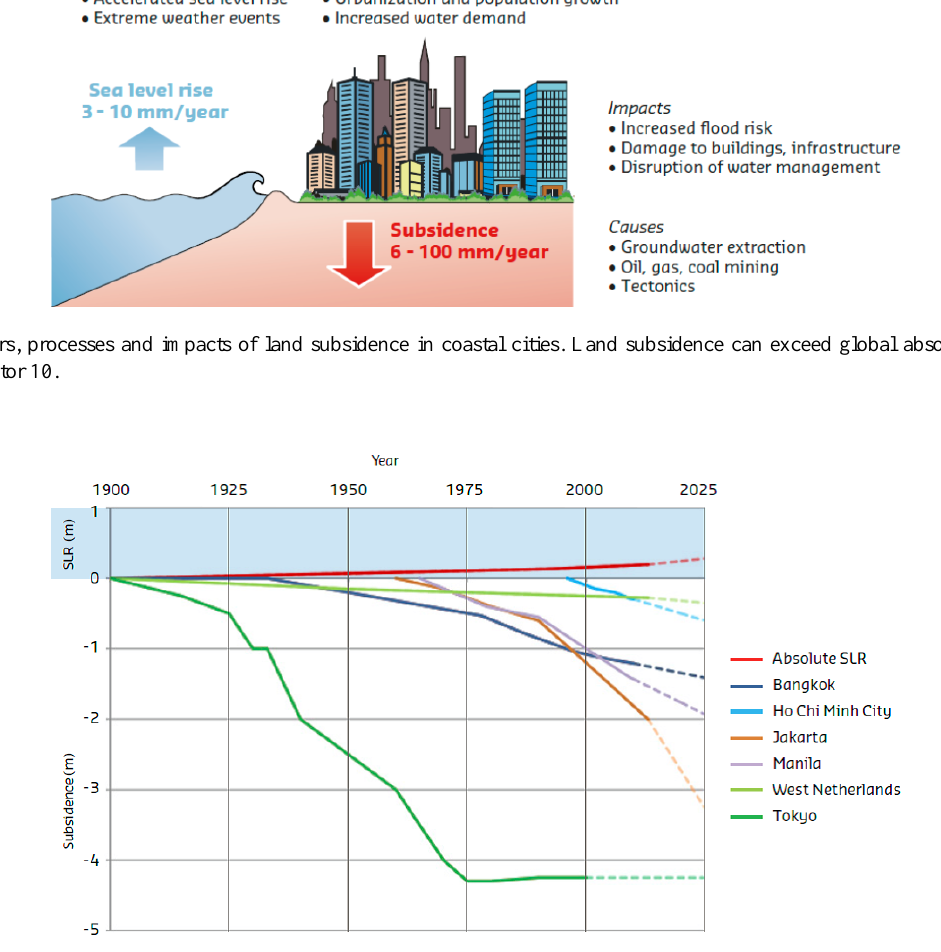
Figure 2. Subsidence history (cumulative) in a series of coastal cities around the world. Absolute sea level rise is depicted as reference. Subsidence can differ considerably within a city area, depending on groundwater levels and subsurface characteristics. Values provided here can be seen as average for the local subsidence hotspots. Some cities are currently seeing an acceleration of subsidence as a result of economic growth. Tokyo stands out as an example where subsidence has stopped after successful mitigation measures were implemented. The caption of Table 1 provides references.